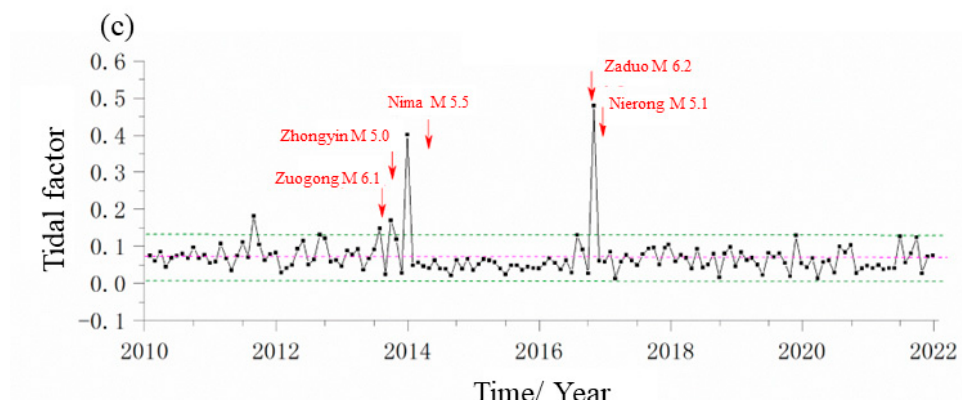
Figure 4. Annual dynamic characteristics of the water level, obtained via a modification of the method by Gesang et al. [30]. ( a ) Water level variation (unit: m). Red frame indicates the external interference. ( b ) Precipitation variation every 10 days (unit: mm/h). ( c ) Tidal factors from 2012 to